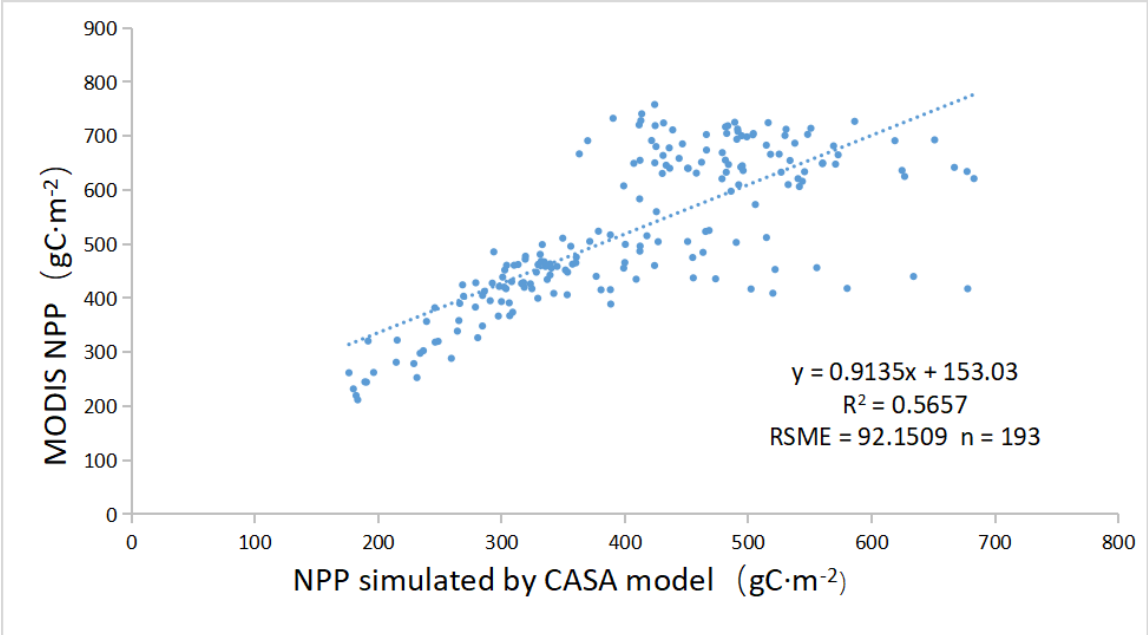
Figure A2. Comparison of NPP obtained from the CASA model and MODIS products in 2010.